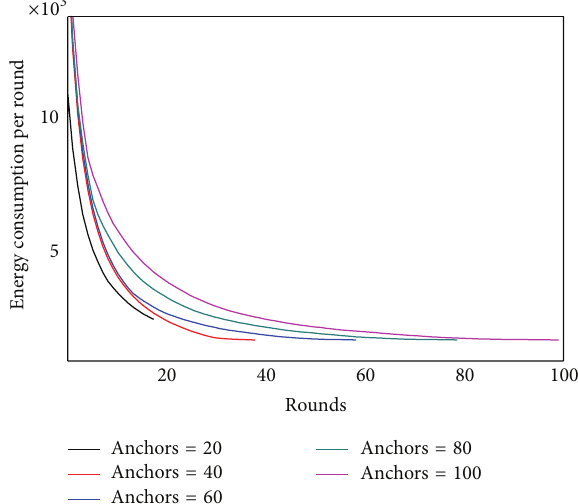
Figure 26: Energy per round under different numbers of anchor (theoretical